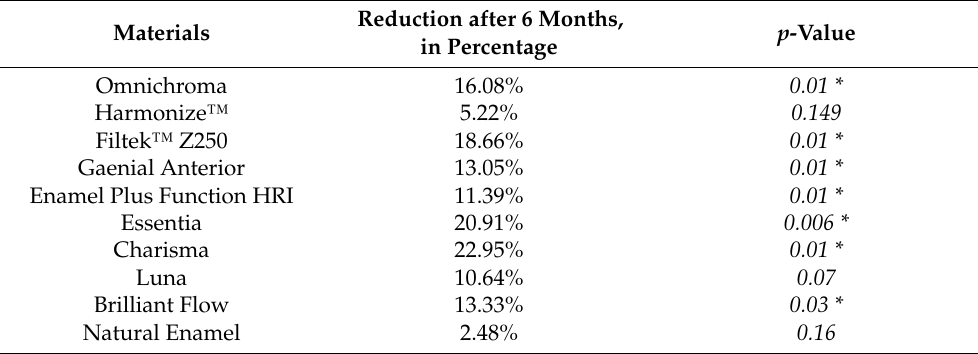
Table 2. Reduction of the fluorescence intensity values after the second measurement for each material and the enamel specimens; p values are based on Mann–Whitney nonparametric